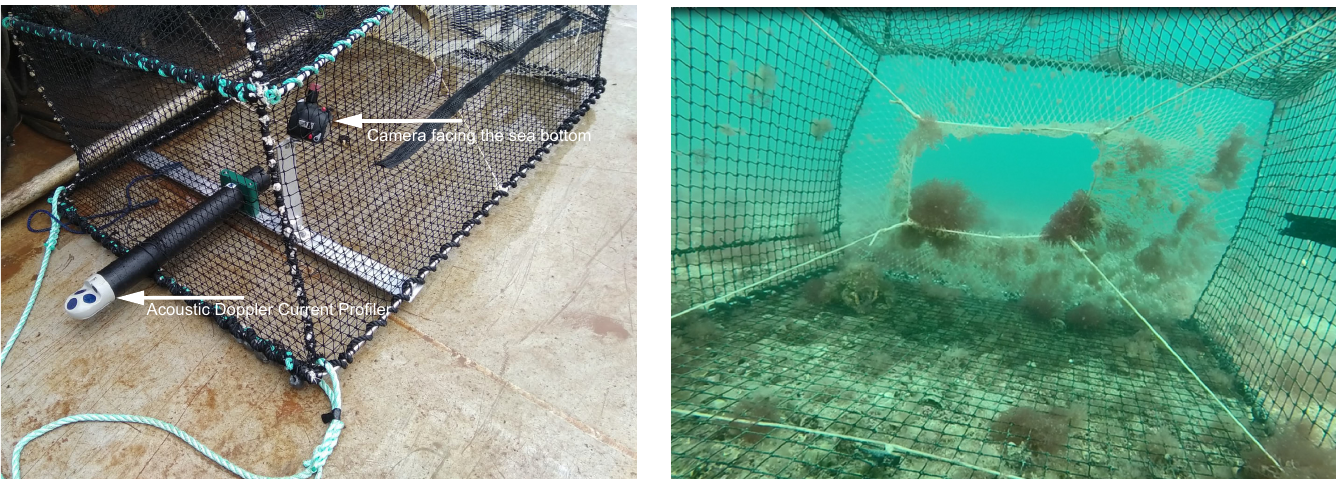
Fig 4. Position of the camera facing the sea bottom and of the Acoustic Doppler Current Profiler (left panel) and View of the bottom from the camera set to quantify the swept distance during retrieval (right panel).